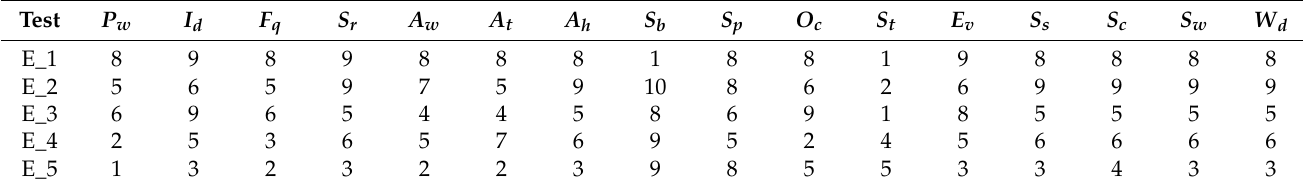
Table 8. Orthogonal test parametric arrangement for sprinkler drip irrigation in clay